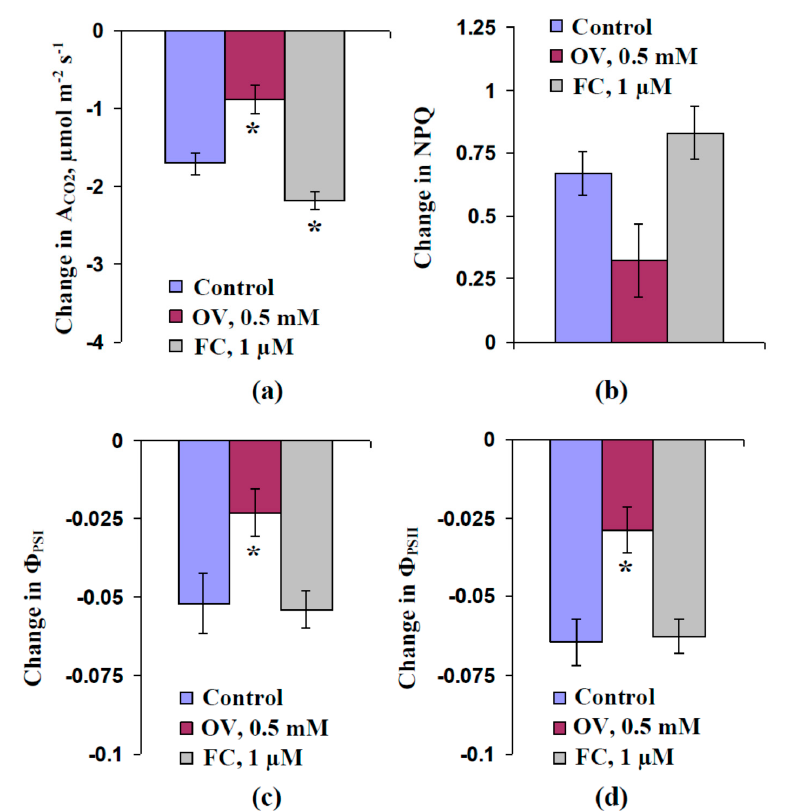
Figure 4. Magnitudes of local burning-induced changes in photosynthetic CO 2 assimilation (A CO2 ) ( a ), non-photochemical quenching of chlorophyll fluorescence (NPQ) ( b ), and quantum yields of photosystems I ( Φ PSI ) ( c ) and II ( Φ PSII ) ( d ), in the second leaf of pea seedlings under control conditions and after preliminary treatment by sodium orthovanadate (OV) and fusicoccin (FC) ( n = 5–6). The preliminary OV (0.5 mM) and FC (1 µ M) treatments of the second mature leaves in